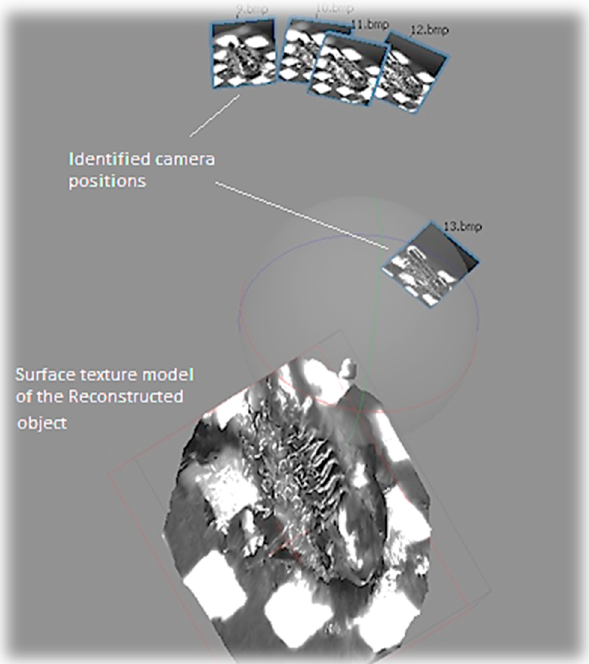
Figure 7. Images identified by absolute light.